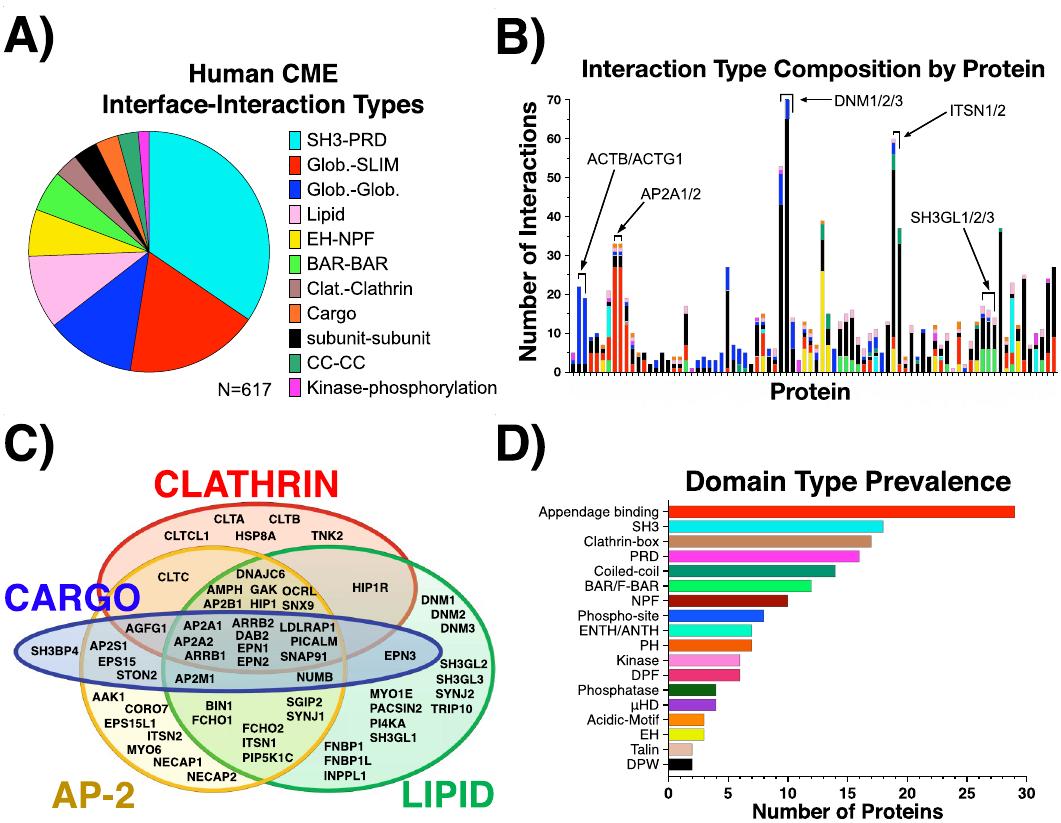
Figure 3. Domain types and interaction pairings in the network are dominated by binding mediated by short linear motifs (SLiMs). ( A ) The types of interaction pairings in the human CME network. PRDs, SLiMs, NPF, and Clat. categories (see Fig. 2 legend) all involve SLiMs binding to structured/globular domains. ( B ) Prevalence of domain types across all human CME proteins. Counts generated if protein has at least one domain of each type present in the CME IIN. Appendage binding, PRD, clathrin-box, NPF, DPF, acidic motifs, DPW are all SLiMs, ( C ) The majority of proteins in the network bind to at least one of the functionally critical components of the AP-2 complex, clathrin triskelion, lipid, and/or cargo. Proteins that are not present in this core set are cytoskeletal. ( D ) Interface-interaction composition profile of human CME proteins, listed alphabetically along the x-axis. Counts generated if protein contains either domain involved in interface-interaction listed. Self- interactions were counted once. Domain names are defined in Fig.